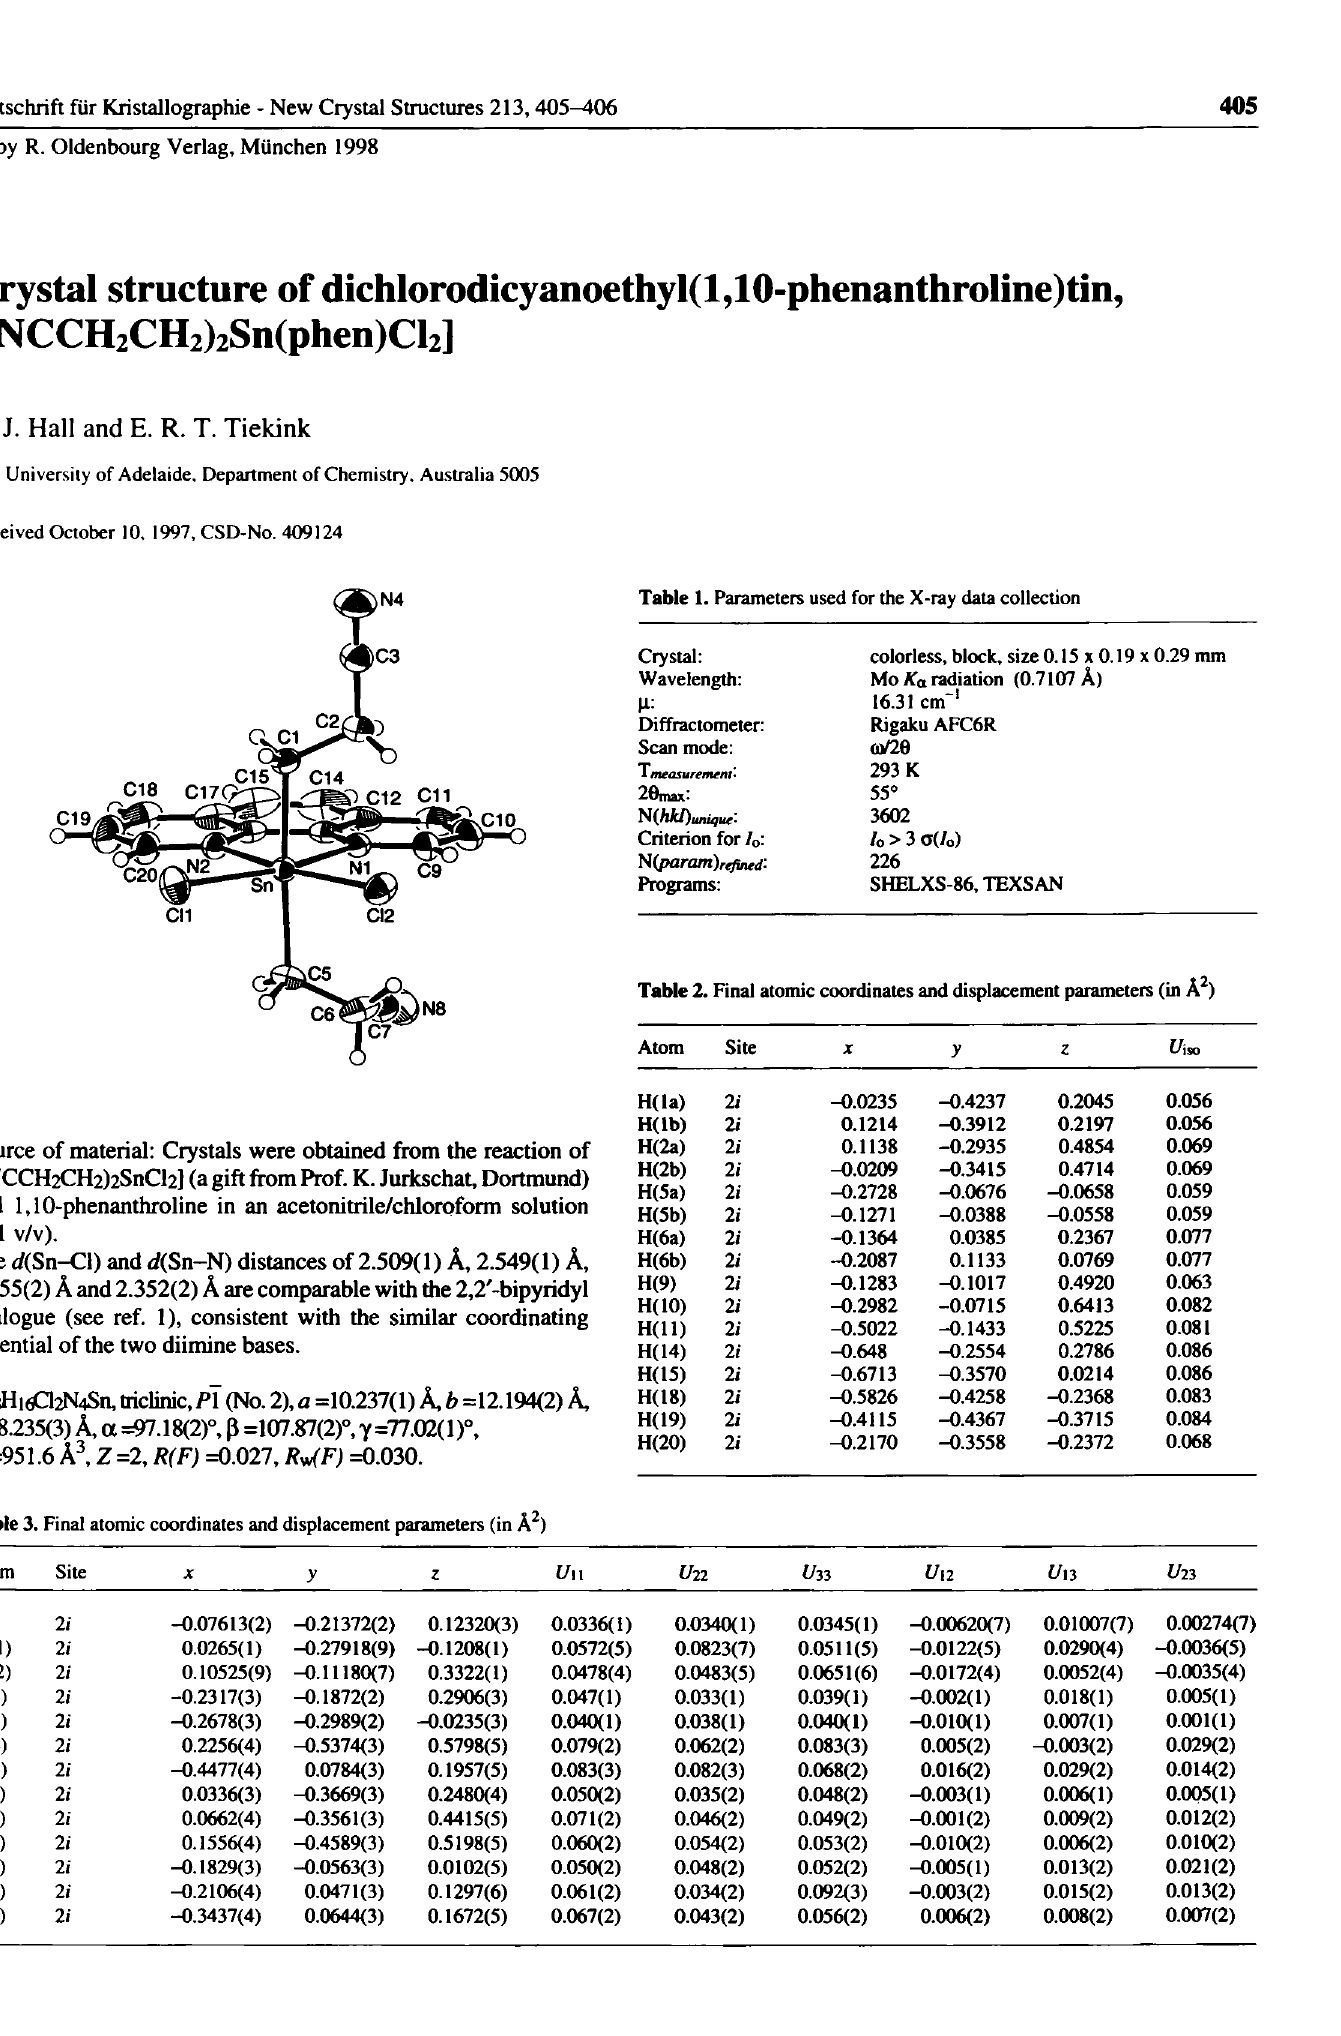
Table 3. Final atomic coordinates and displacement parameters (in Â^)